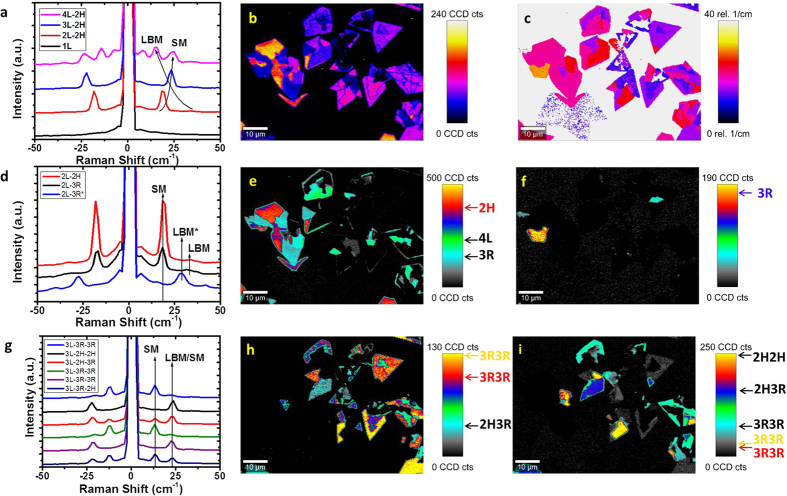
(a) Low-frequency Raman spectra of SMs and LBMs of 1, 2, 3, and 4L 2H MoSe2. (b) Peak intensity map over the range 10–50 cm−1. (c) Map of position of maximum peak intensity of the low-frequency Raman modes in the range of 0–40 cm−1. (d) Low-frequency Raman spectra of SMs and LBMs of 2H and 3R stacking configurations in 2L MoSe2. (e) Peak intensity map for 2L MoSe2 SM at ~18 cm−1. (f) Peak intensity map for 2L MoSe2 LBM at ~29 cm−1. (g) Enhanced low-frequency Raman spectra of SMs and LBMs of 2H and 3R combination stacking configurations for 3L MoSe2. (h) Peak intensity map for 3L MoSe2 at ~13 cm−1. (i) Peak intensity map for 3L MoSe2 at ~24 cm−1.